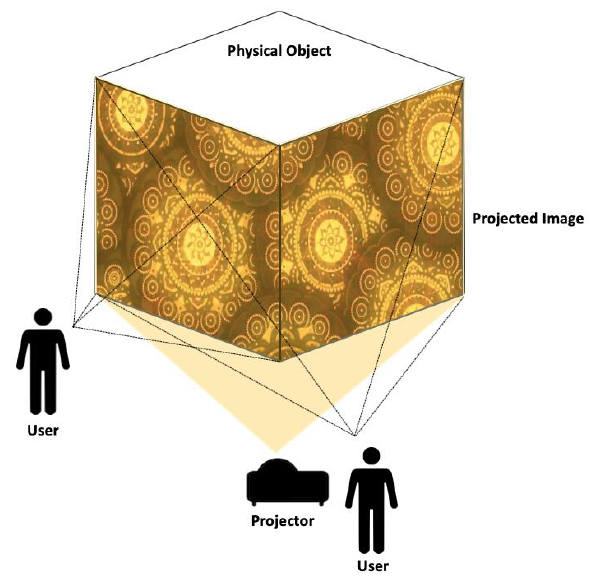
Figure 1. Basic Concept of Spatial Augmented Reality.